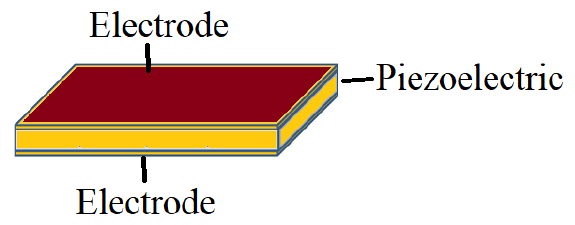
Figure 1. Schematic of piezoelectric and electrodes in a BAW